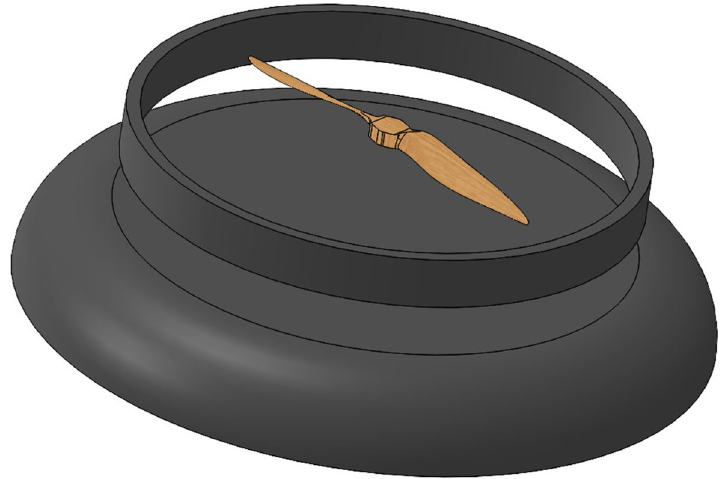
Fig. 6 CAD model of conventional